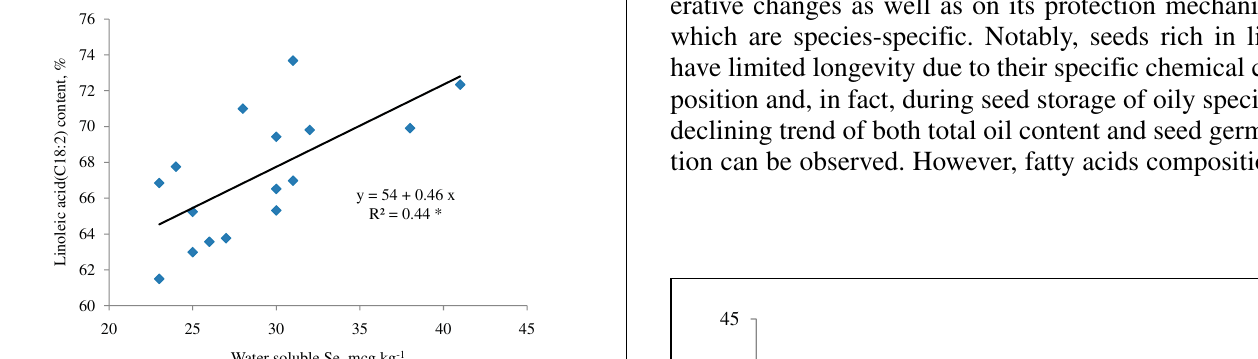
Table 4 - Fatty acids composition (%) of seed oil in perennial onion species